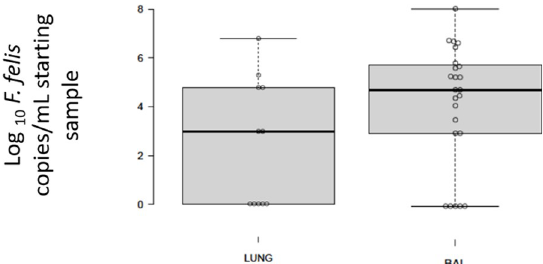
Fig 4. F . felis copy number as detected using NGS or qPCR in BALF samples. A comparison of log 10 F . felis copies as detected using NGS or qPCR in BALF samples from 24 cats with lower airway disease (Australia and Northern Italy) compared to 16 necropsy lung specimens from cats in northern Italy. Note that as a generality, cats with lower airway disease tended to have substantially higher copy numbers of F . felis than present in necropsy lung specimens.